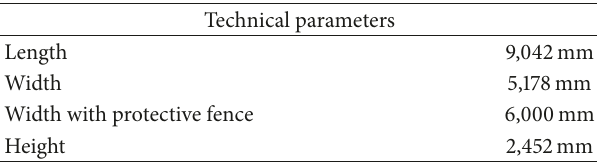
Table 5: APT facility dimensions.